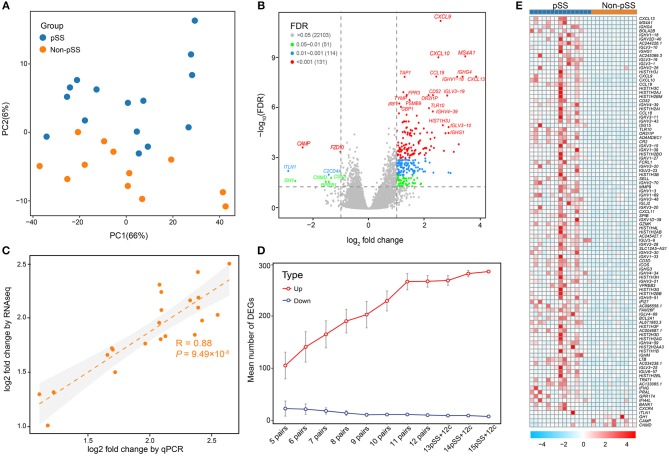
Comprehensive transcriptome analysis revealed massive gene up-regulation in the development of pSS. (A) PCA illustrating the individual differences in the RNA-seq expression profiles between the pSS and non-pSS groups for 27 samples. The red and blue circles represent the case and non-pSS groups, respectively. (B) Volcano plot highlighting DEGs in pSS. The red dots illustrate the 131 up-regulated or down-regulated DEGs (adjusted P < 0.001 and log2 FCs >1). The blue and green dots show, respectively, 114 DEGs with adjusted P < 0.01 and 51 DEGs with adjusted P < 0.05. (C) Correlations between RNA-seq and qPCR for the log2 FCs of DEGs, as analyzed by the Pearson's test (R = 0.88, P = 9.49 × 10−8). (D) Saturation curve showing the means and confidence intervals of DEGs with sample sizes ranging from 5 to 15 that were randomly selected from 15 pSS and 12 non-pSS. (E) Heatmap of the top 100 DEGs. “Red” indicates high relative expression, and “blue” indicates low relative expression.